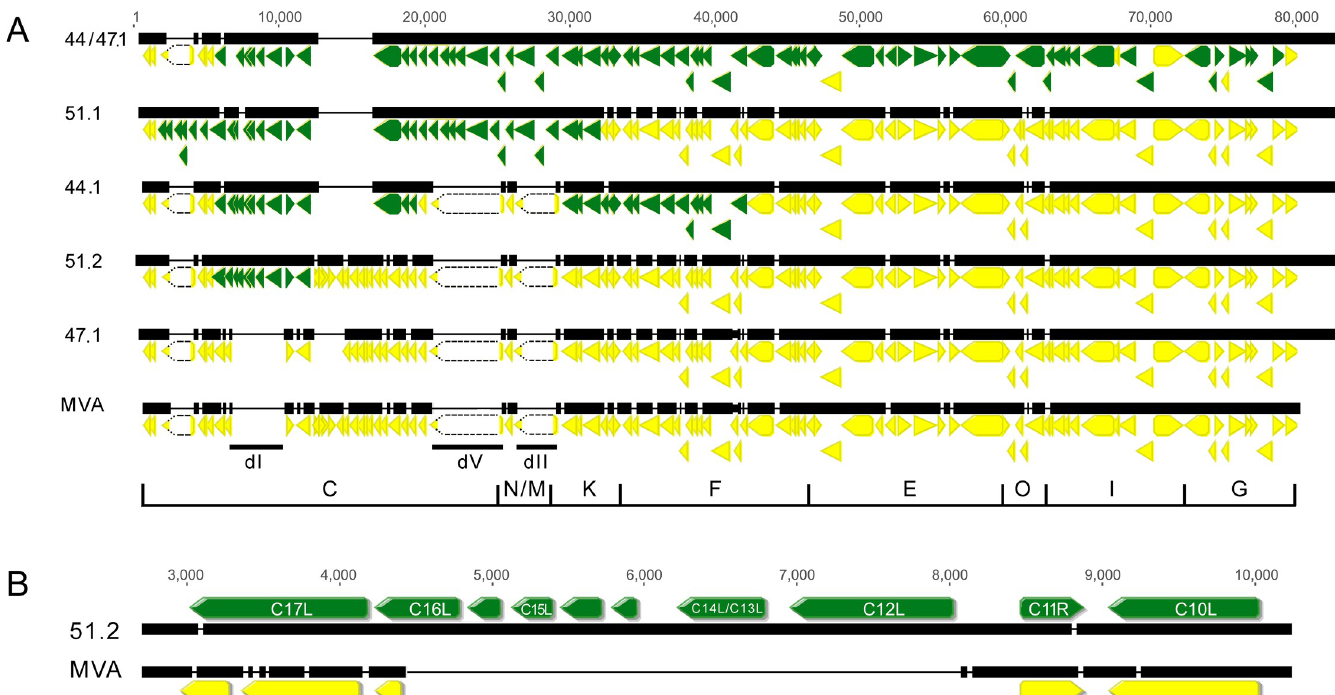
Fig 6. Multiple alignment of genome sequences of the left ends of MVA and HRE MVAs. (A) Alignment of left 80,00 bp. Arrows indicate the lengths and directions of ORFs. Solid yellow arrows, ORFs common to MVA; Green arrows, ORFs that differ from MVA by at least one nucleotide indicating they were derived by recombination from the cosmids; white arrows with dotted borders represent very small anomalous ORFs that are not to scale and connect the boundaries of deletions; dI, dV and dII indicate the sites of three of the large deletions in MVA. The corresponding Hind III fragments are shown below the alignments. (B) Alignment of the left 10,000 bp of MVA and v51.2. Names are provided for those ORFs annotated in the genome of the Copenhagen strain of VACV. C14L and C13L are separate ORFs in Copenhagen but a single ORF in